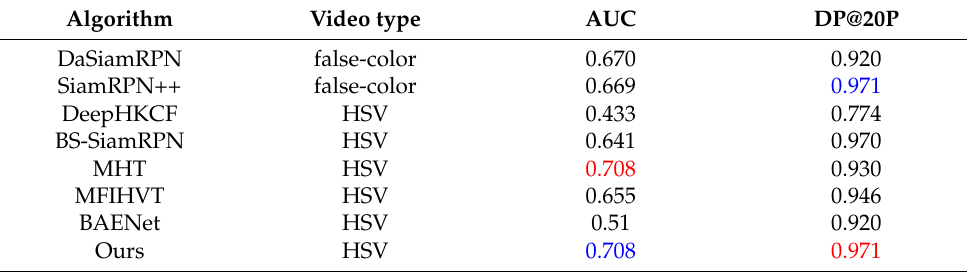
Table 3. Performance comparison with other trackers in terms of deformation